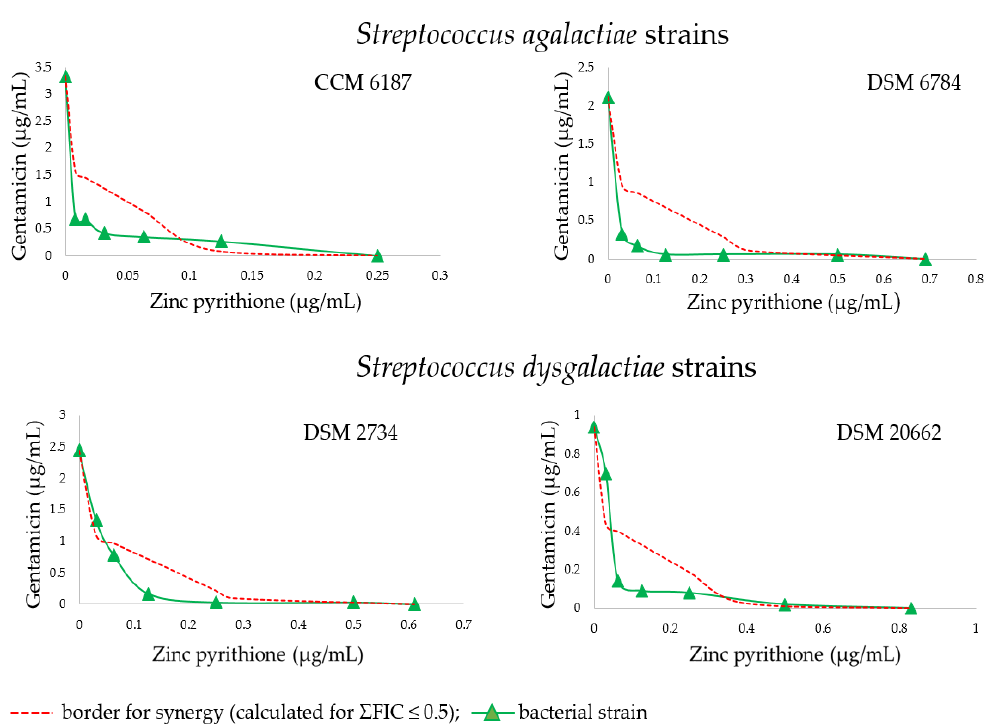
Figure 1. Isobolograms of the interactions between gentamicin and zinc pyrithione binary combinations against Streptococcus agalactiae and Streptococcus dysgalactiae strains. Synergy (ΣFIC ≤ 0.5).